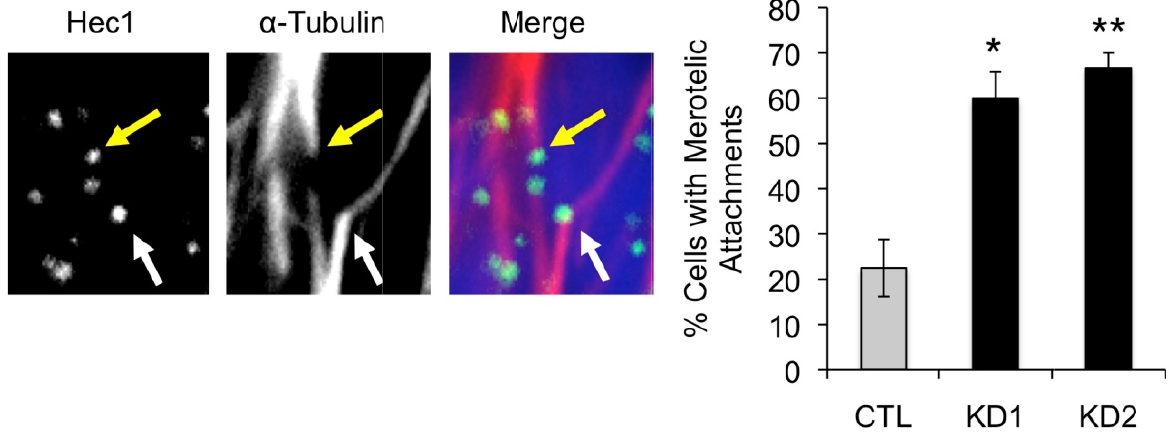
e 3. P190B attachm ments. Rep antibo dies agains attachm ment and w and p1 190B ** p =